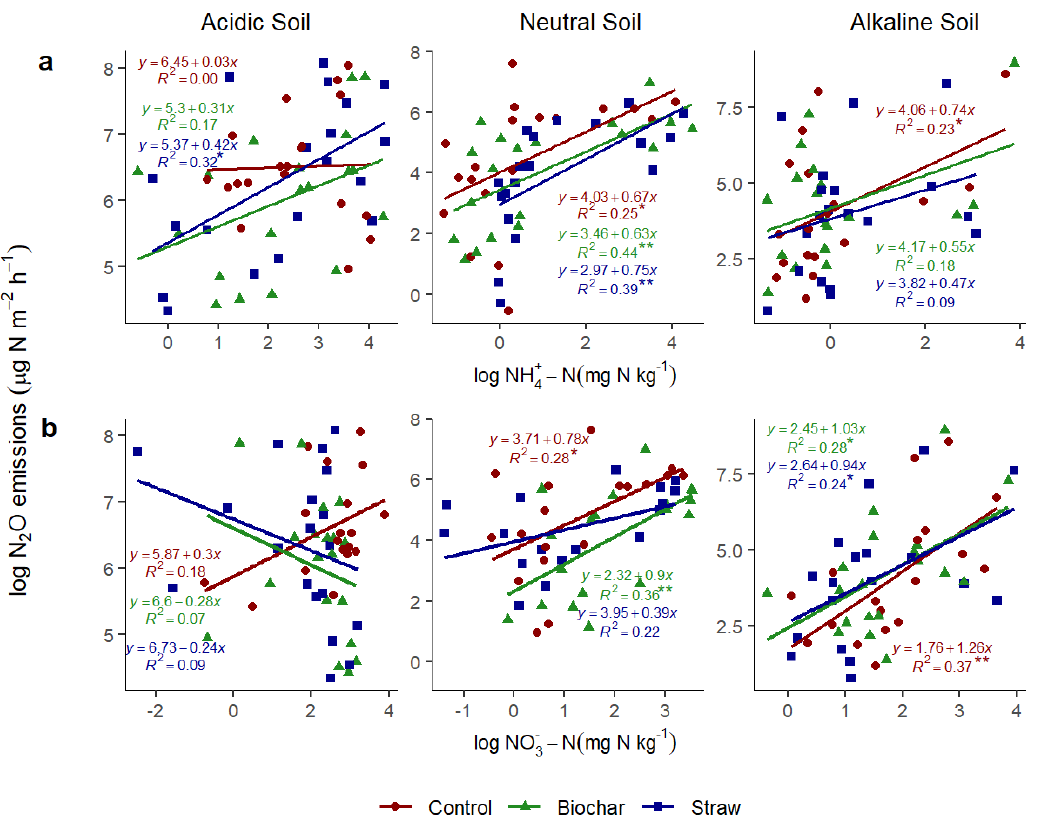
Figure 8. The relationships between N 2 O emissions and ( a ) soil NH 4+ -N and ( b ) soil NO 3 − -N under soils with different pH treated with biochar and straw averaged over 19 days. Note: (*) shows that the strength of the relationship is significant at p -value ≤ 0.05, and (**) shows that the strength of relationship is significant at p -value ≤ 0.01. The axes of the different natural soil pH values are on different scales, and the log designation refers to natural logarithms.